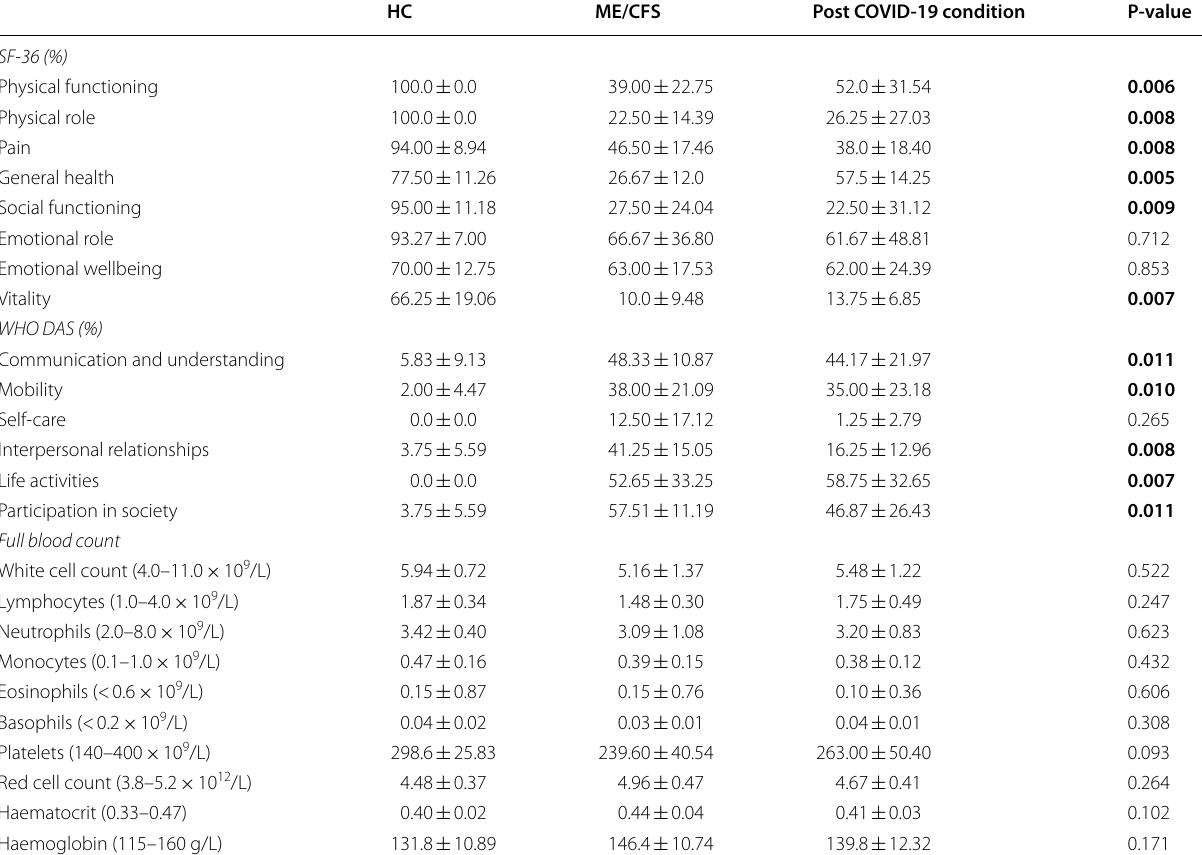
Table 2 Participant quality of life, disability scores and